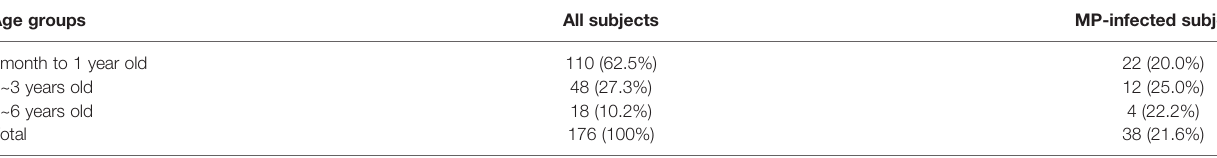
TABLE 3 | Age distribution of all and MP-infected subjects from Xiangya